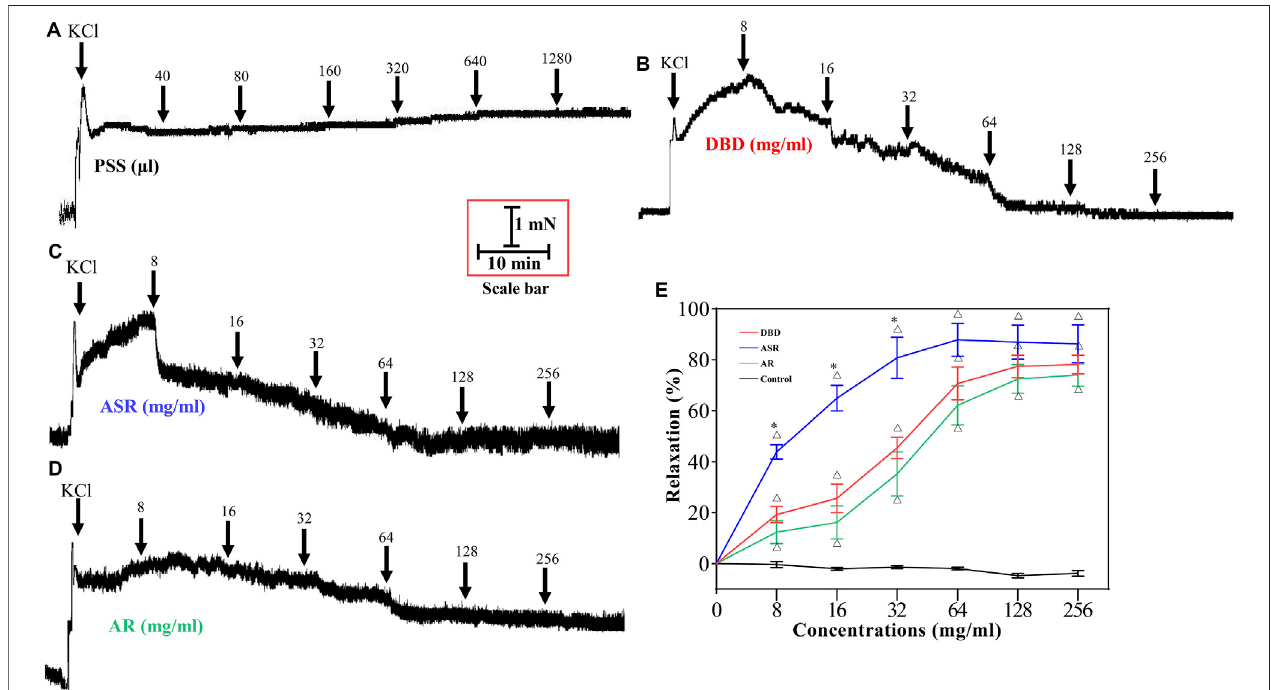
FIGURE 5 | Effect of DBD, ASR, and AR on vascular tension of 60 mM KCl precontracted MCA of rats. Diagrams of the effect of cumulative addition of PSS (A) , DBD (B) , AR (C) , and ASR (D) on KCl preconstricted MCA of rats. (E) Comparison of vasodilators by DBD, ARS, and AR on MCA of rats. Data were expressed as the mean ± S.E.M.(n (cid:2) 5). △ p < 0.05vsthecontrolgroup;* p < 0.05vstheDBDgroup.DBD,DangguiBuxuedecoction.ASR,AngelicaeSinensisRadix.AR,AstragaliRadix. MCA, middle cerebral artery.